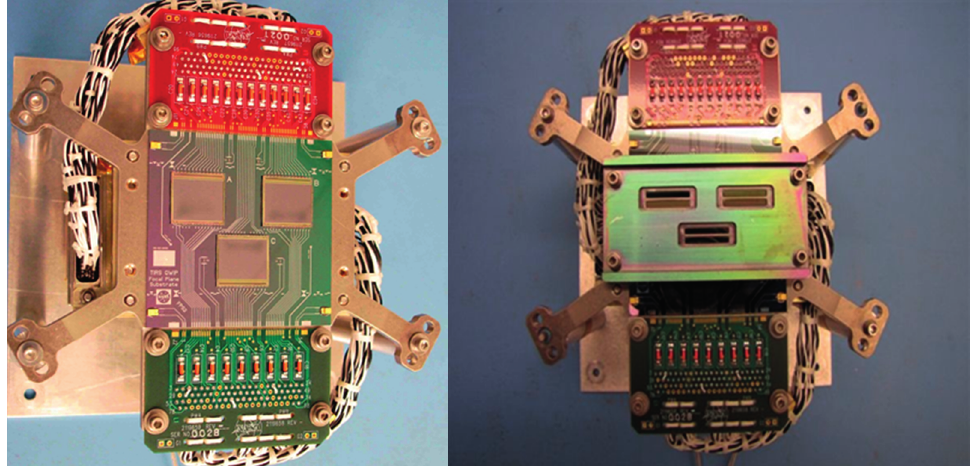
Figure 5. The TIRS flight focal plane with the three QWIP arrays exposed ( left ) and the focal plane with the filter assembly installed ( right ). The six filter segments (two over each array) are clearly visible on the right. The filter assembly is coated on both the top and the bottom with a “black mirror” coating that is less than 5% reflective over the roughly 9–14-  m spectral range over which the QWIPs are active. The coating, which appears greenish in the photo below, limits scattering into the active area of the